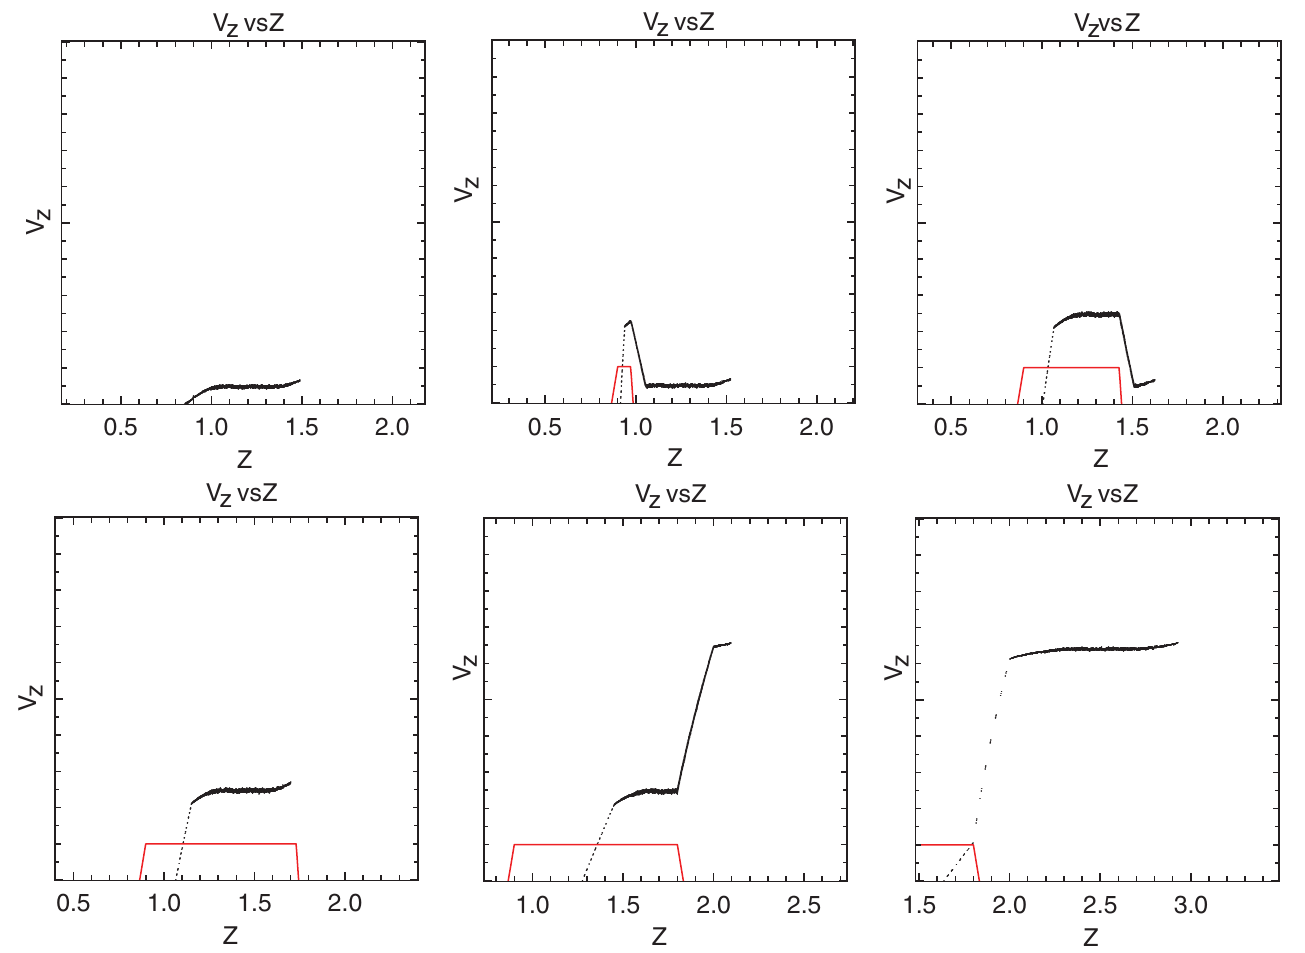
FIG. 1. (Color) Snapshots of the phase space of the ion beam (black) in the beam frame being accelerated by a voltage waveform (red) in snowplow mode. The helix starts at z ¼ 0 : 7 m and ends at z ¼ 1 : 9 m . In the first four panels, the voltage wave sweeps through the ion beam and reaches the end of the helix. Then the ion beam gains an extra voltage (cid:1) V when it exits the helix tube, as shown in the last two panels.